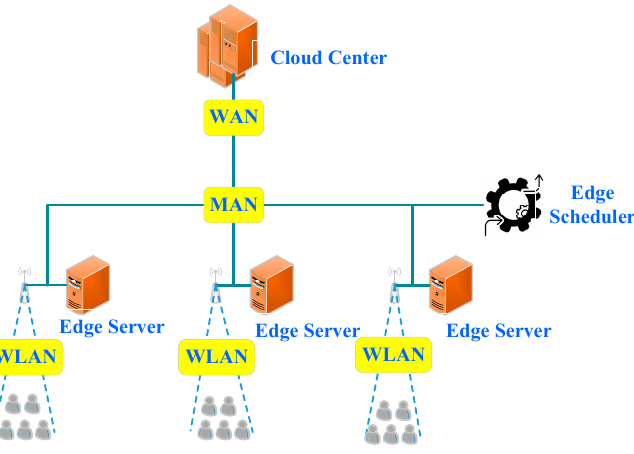
Figure 5. Scheduler-based edge-cloud computing.